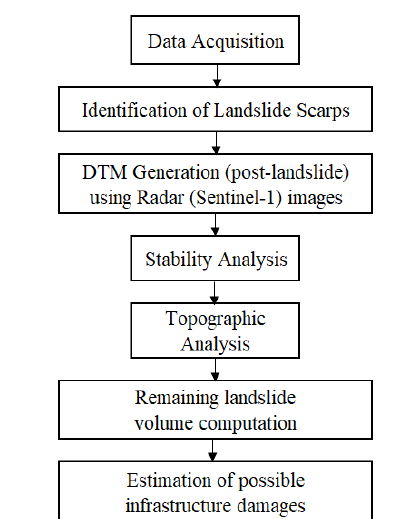
Figure 4 . General methodology of this study.